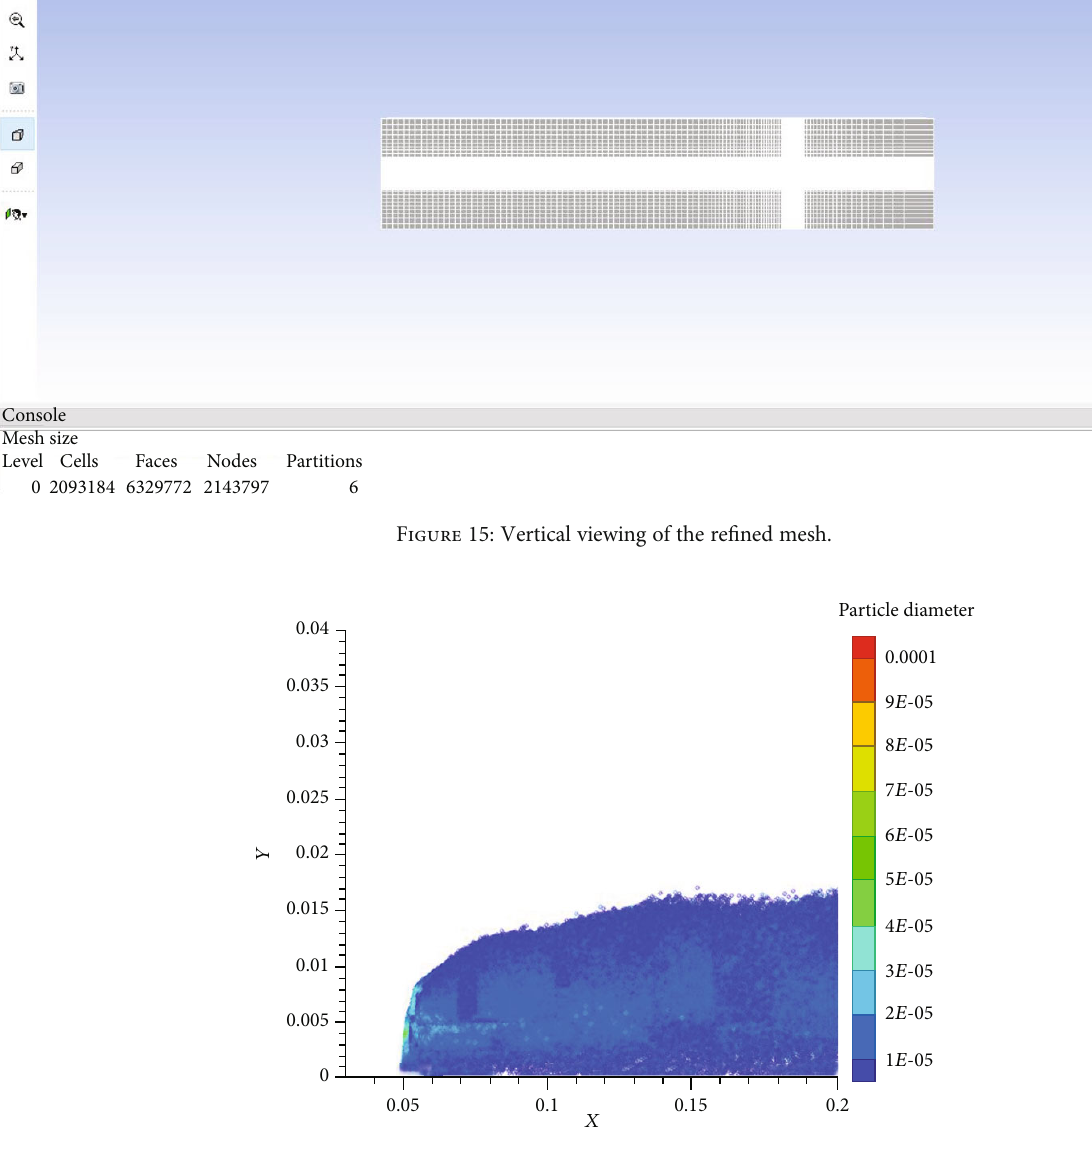
Figure 16: Spray penetration at t = 0 : 5ms with high grid